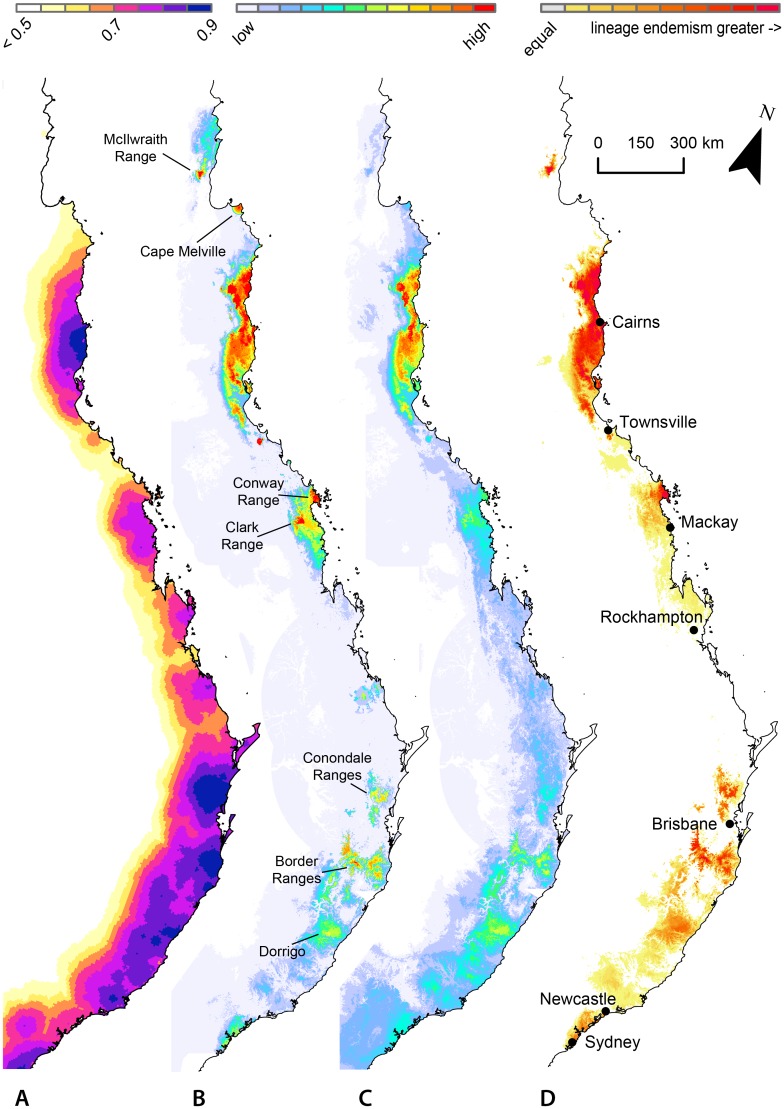
A) Paleo habitat stability of rainforest since 120 ka using the dynamic stability model allowing dispersal at 10 m yr-1. B) Model-weighted lineage endemism peaks in the AWT just north of Cairns, and shows distinct highlights in a small subset of each rainforest region, such as Cape Melville in CYP, Conway Range and Eungella in MEQ, and the Border Ranges just south of Brisbane. C) Model-weighted species richness. D) Lineage endemism minus species endemism. Red areas have far greater lineage than species endemism, identifying concentrations of spatially restricted diversity, which would be missed in a species-level analysis. Colors by quantile classes for each map. Note that for compact map presentation, north is offset by 20° as indicated.